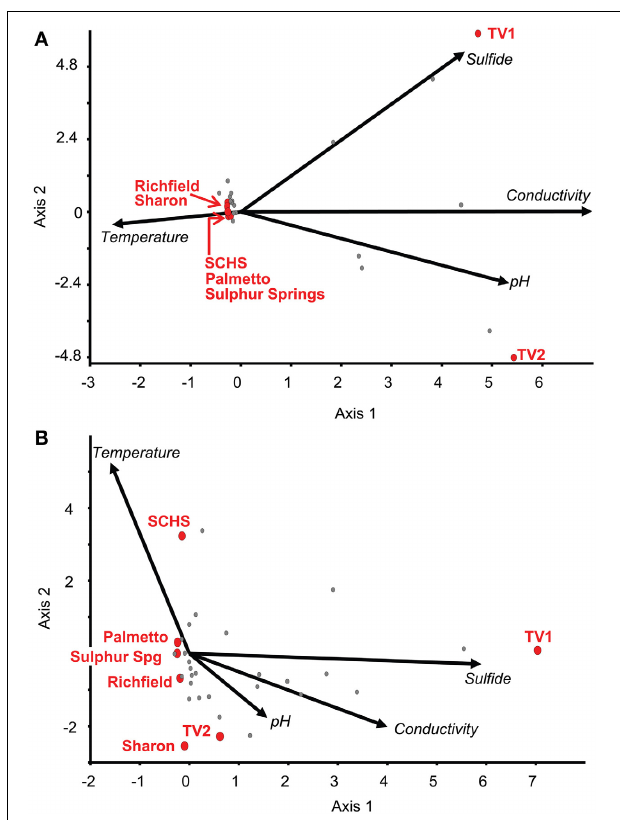
FIGURE 5 | CCAs of 16S rRNA pyrosequence OTUs belonging to (A) Epsilonproteobacteria and (B) Gammaproteobacteria . Red dots represent the ordination of the sampled spring diversity. Gray dots represent OTUs defined by 16S rRNA gene pyrosequences for each class from the springs. Arrows represent environmental